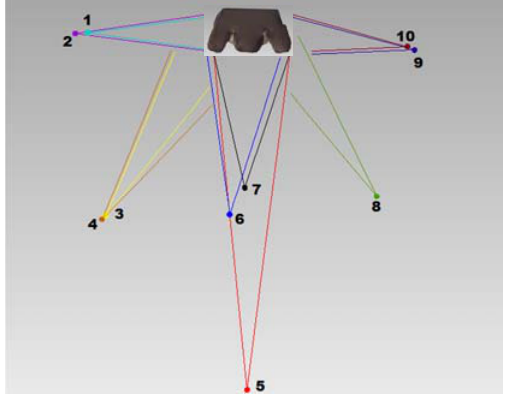
Figure 6. Positions of the scan stations